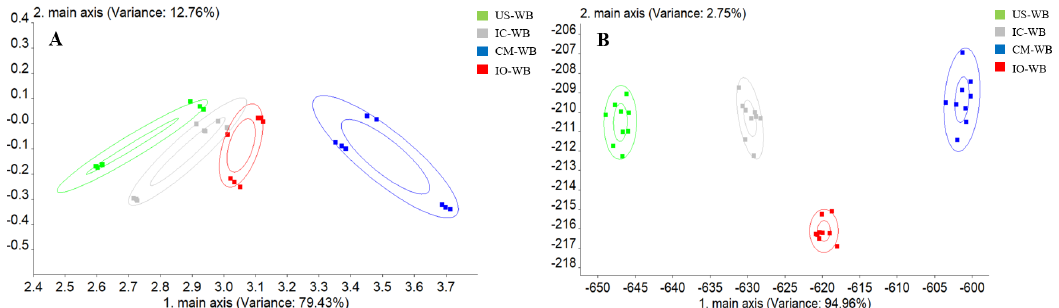
Figure 5. Principal component analysis ( A ) and linear discriminant analysis ( B ) of unfermented and fermented wheat brans after 6 days of fermentation. US-WB, unfermented sterilized wheat bran. IC-WB, Isaria cicadae Miq. fermented wheat bran; CM-WB, Cordyceps militaris fermented wheat bran; IO-WB, Inonotus obliquus fermented wheat bran.